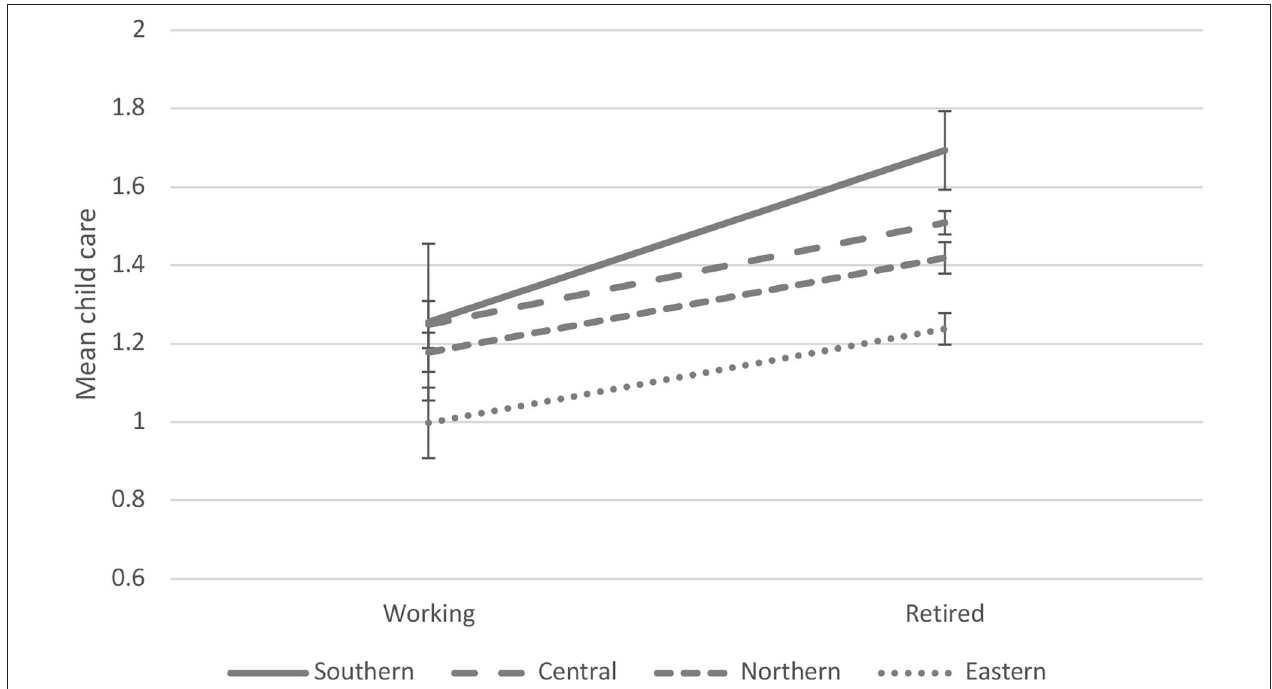
FIGURE 2 | Within-person associations between retirement and grandchild care by European country groups (predictive margins and 95% CI).